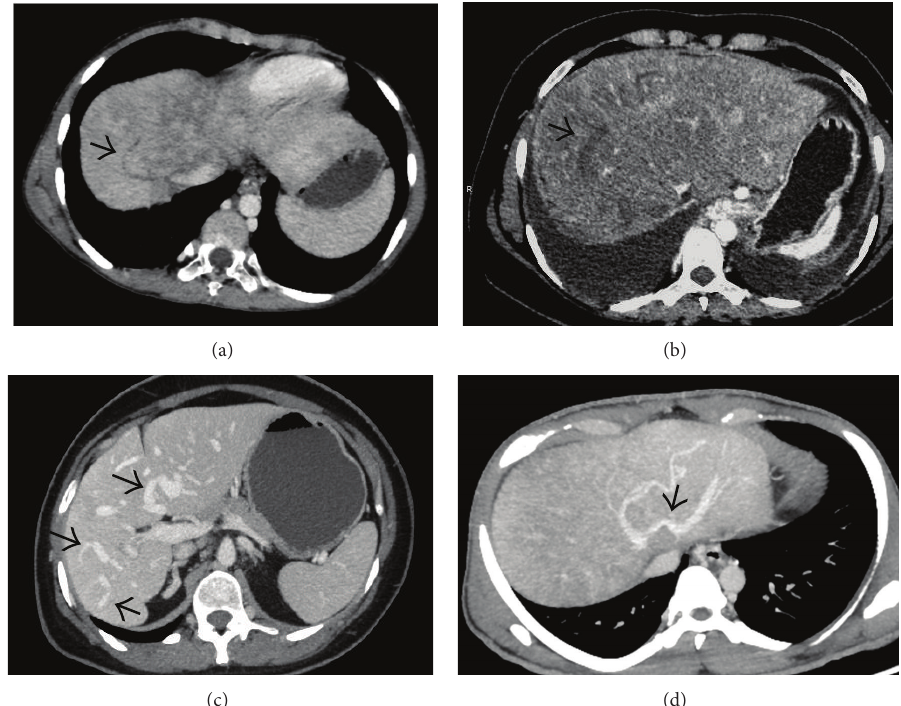
Figure 26: Axial CECT images from four different patients demonstrating comma-shaped intrahepatic collaterals (arrows) demonstrating varying degrees of patency.